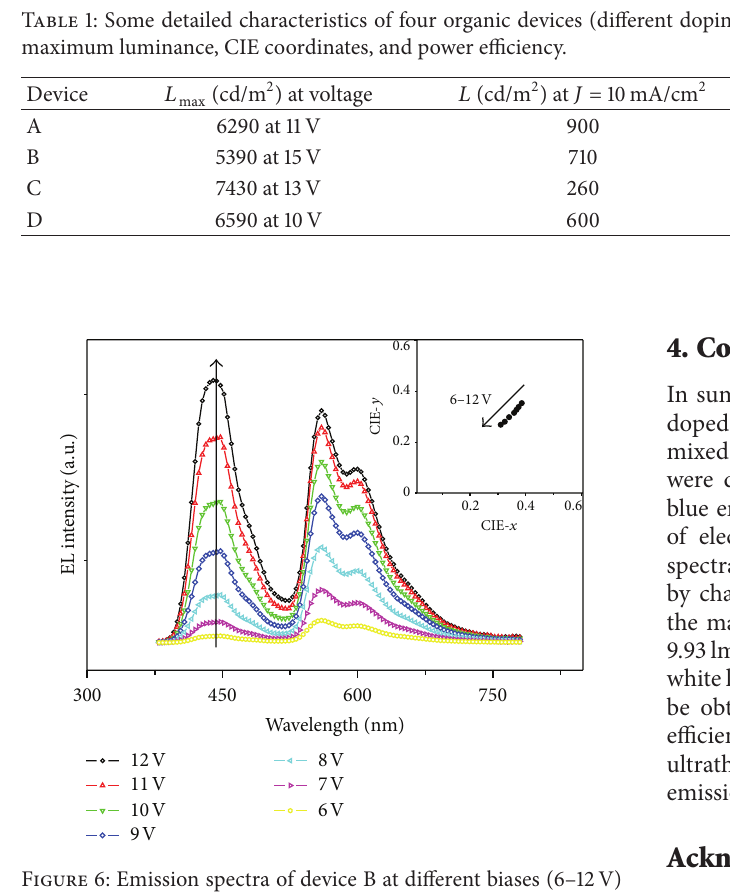
Figure 6: Emission spectra of device B at different biases (6–12V) and the inset was the CIE coordinates ( 𝑥 and 𝑦 ) of corresponding